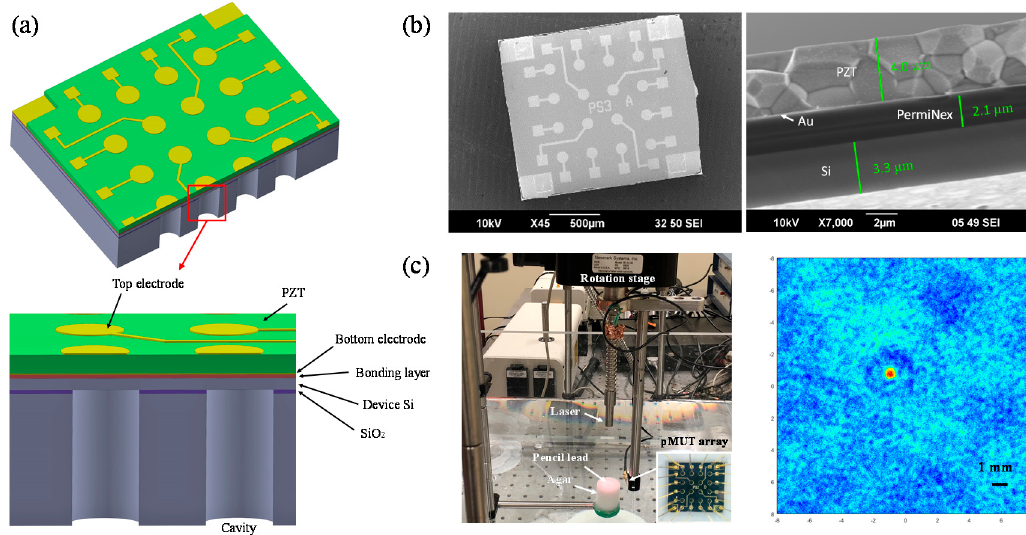
Figure 23. Ceramic PZT-based pMUT arrays for PAI. ( a ) Three-dimensional (3D) model of the pMUT array. ( b ) SEM images of the fabricated pMUT array (left) and its thin membrane in cross-section view (right). ( c ) Experimental setup (left) and reconstructed image (right) in PAI experiments (Reproduced with permission from IEEE [148]).